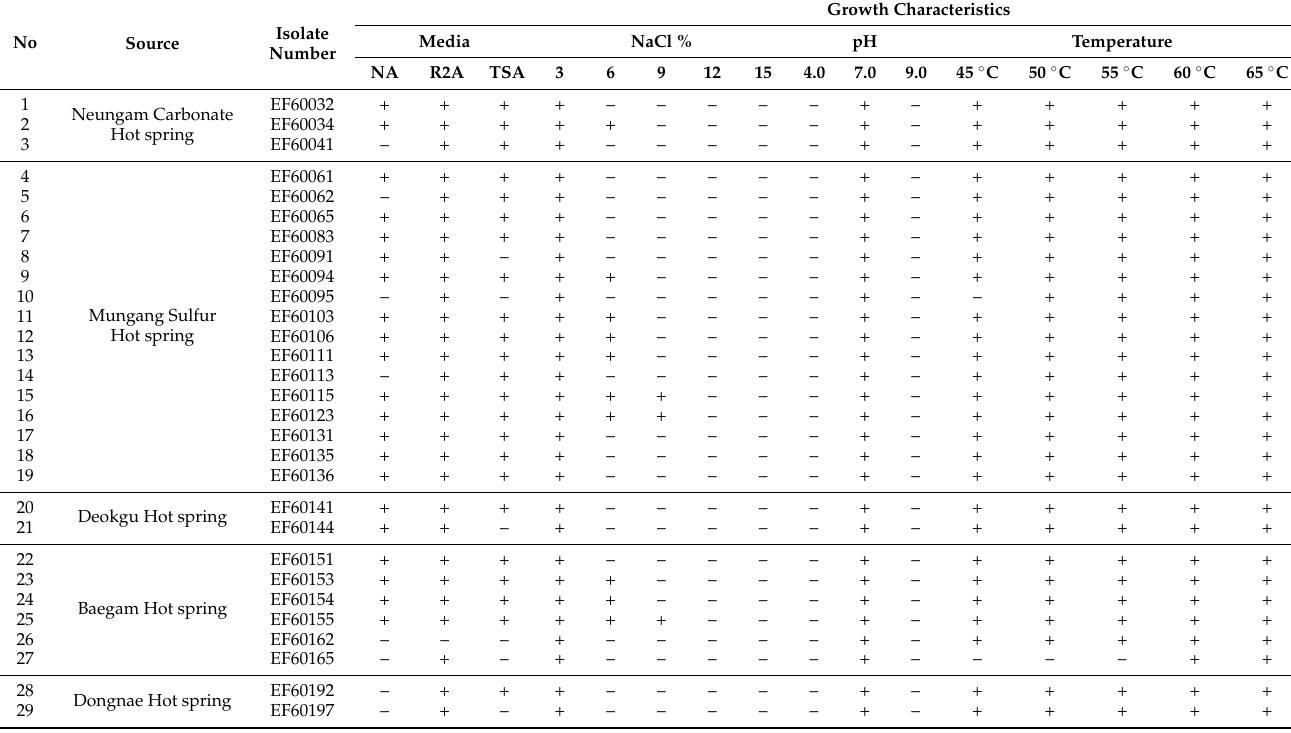
Table 2. Growth characteristics of aerobically cultured thermophilic bacteria isolated from the diverse hot springs in Republic of Korea.